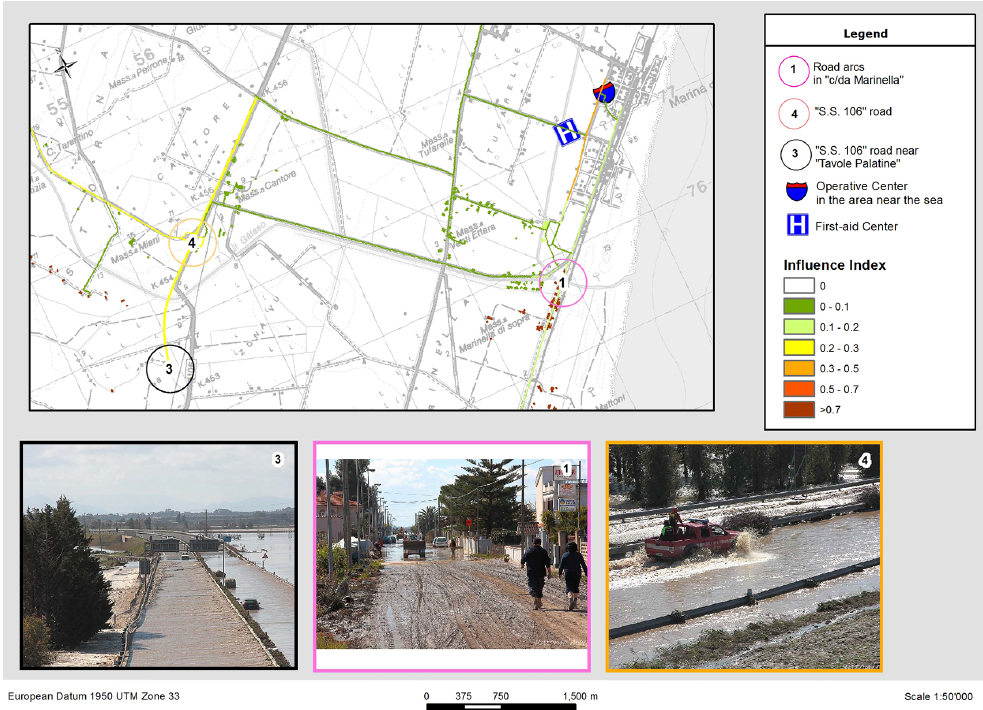
Figure 13. Influence index